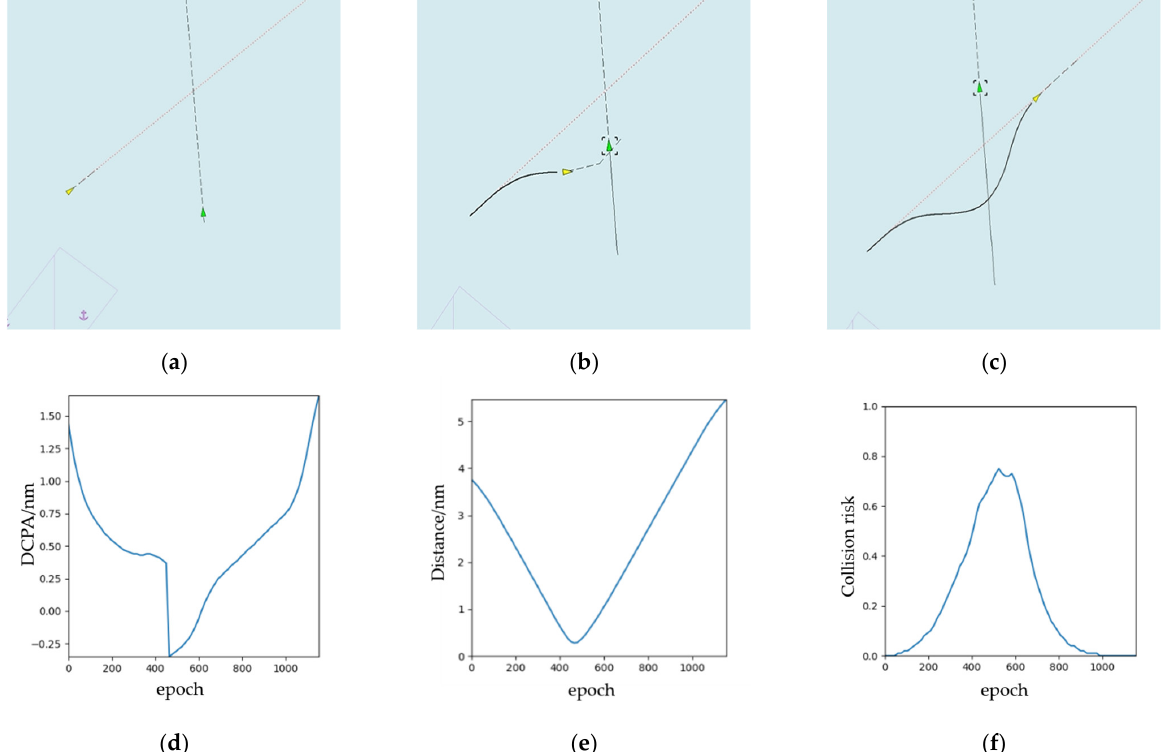
Figure 10. The experimental results (crossing): ( a ) the start time during the collision avoidance process; ( b ) the middle time during the collision avoidance process; ( c ) the end time during the collision avoidance process; ( d ) DCPA; ( e ) distance; ( f ) collision risk.